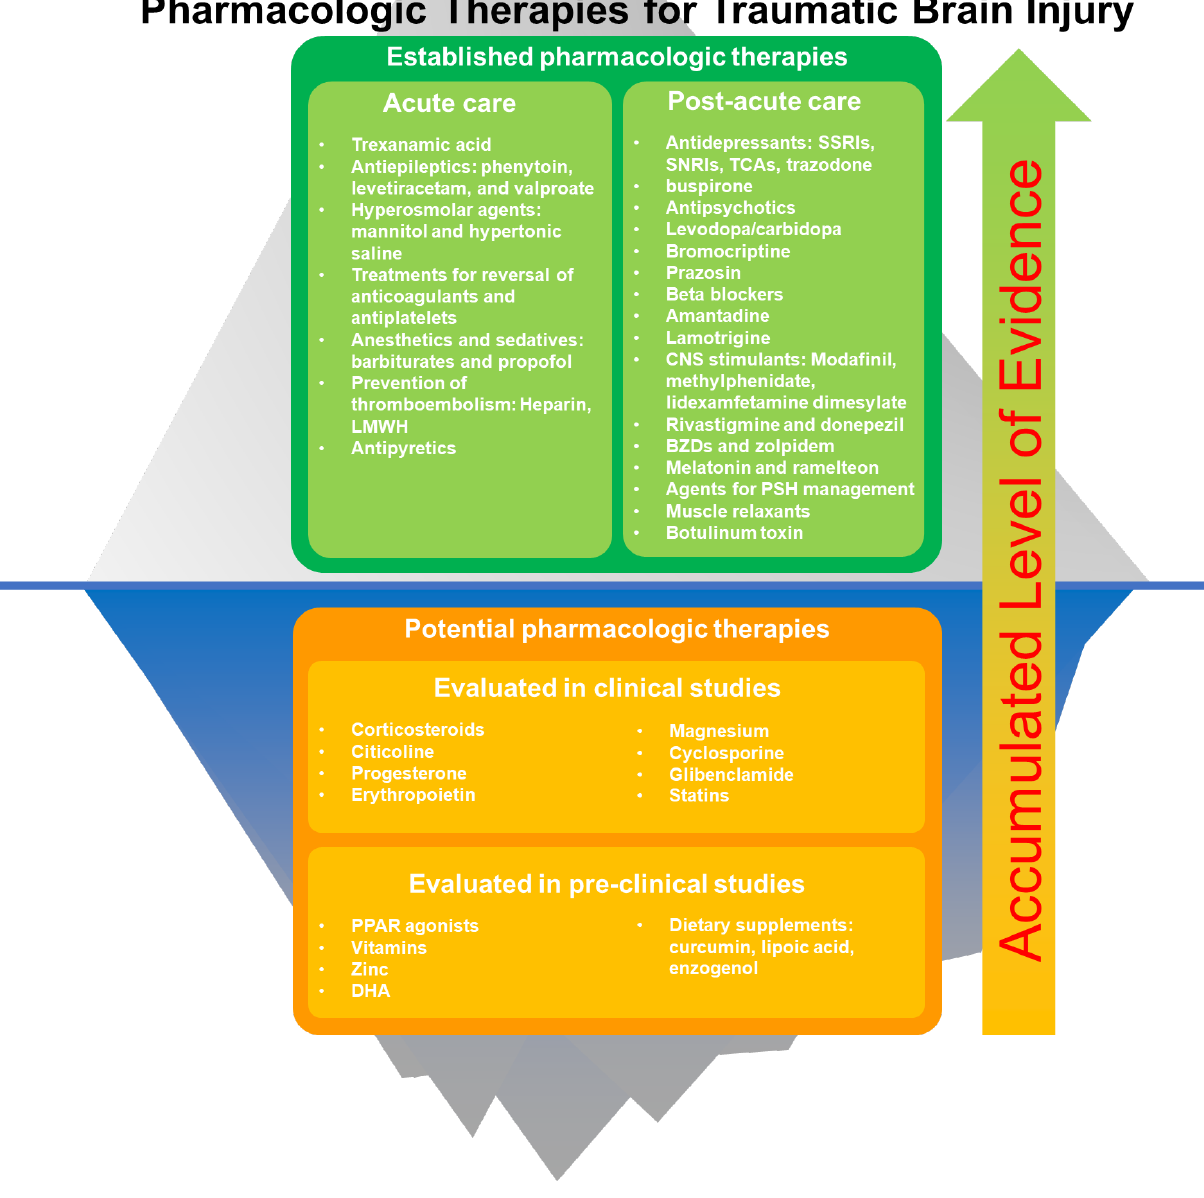
Figure 1. Established and potential pharmacologic therapies for traumatic brain injury. Potential pharmaceutical agents may be accepted into standard practice (“go above the surface”) with the accumulation of clinical evidence.